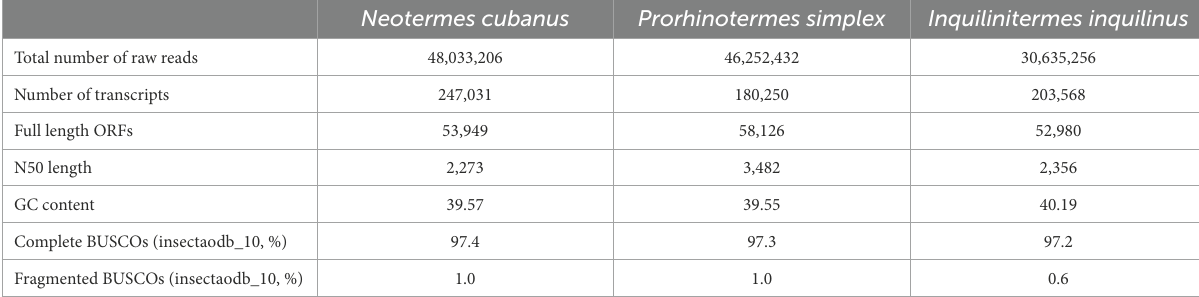
TABLE 2 De novo transcriptome assembly statistics of the three species of termites, N. cubanus , P. simplex , and I. inquilinus